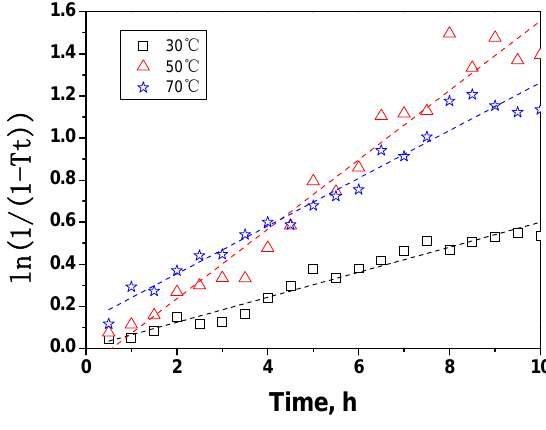
Figure 9. Transformation rate mathematical modeling of crystalline cellulose in